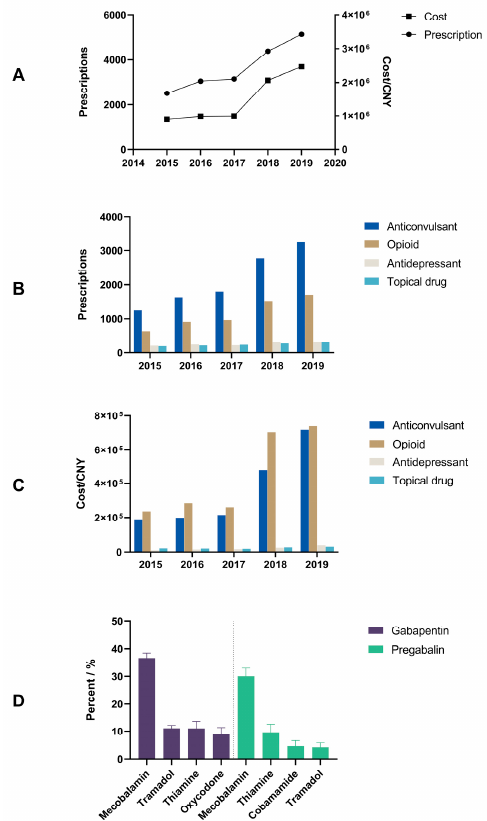
Figure 1. Prescription trends of PHN in six regions of China. ( A ) Annual number of patients and costs; ( B ) total prescriptions of the four classes of drug trends; ( C ) total costs of the four classes of drug trends; ( D ) average ratios of five years in the combination of gabapentin (left) and pregabalin (right). The data are expressed as the mean ± SD of 5 years. Table 1. Demographic characteristics of the study sample.